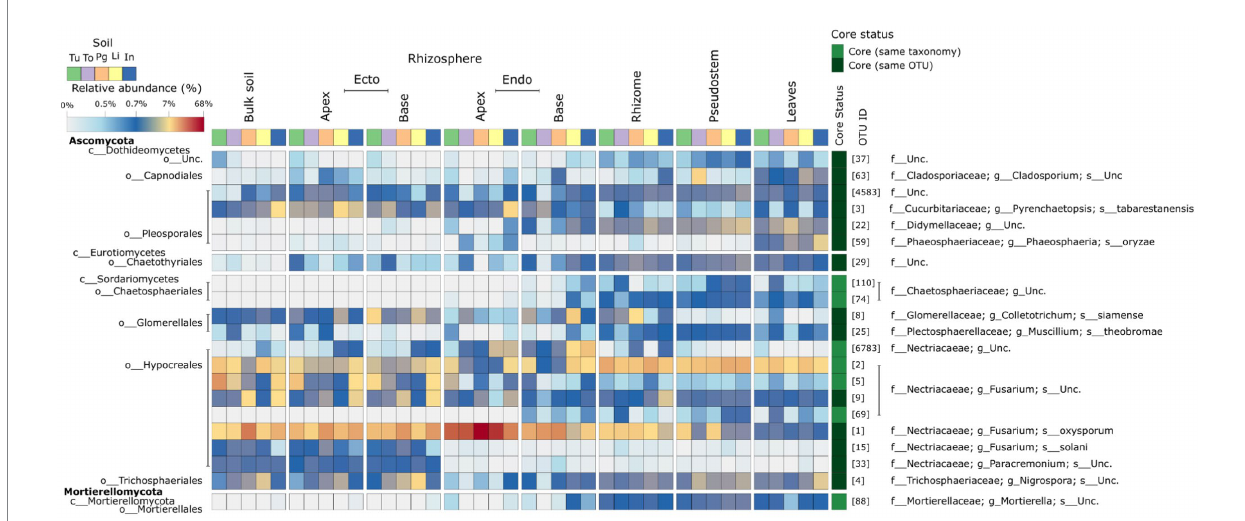
FIGURE 5 A heatmap showing the mean abundance of the core fungal microbiome taxa identified in this study in various Musa (AAA Group, Cavendish Subgroup) ‘Williams’ plant compartments and plants grown in distinct soils.